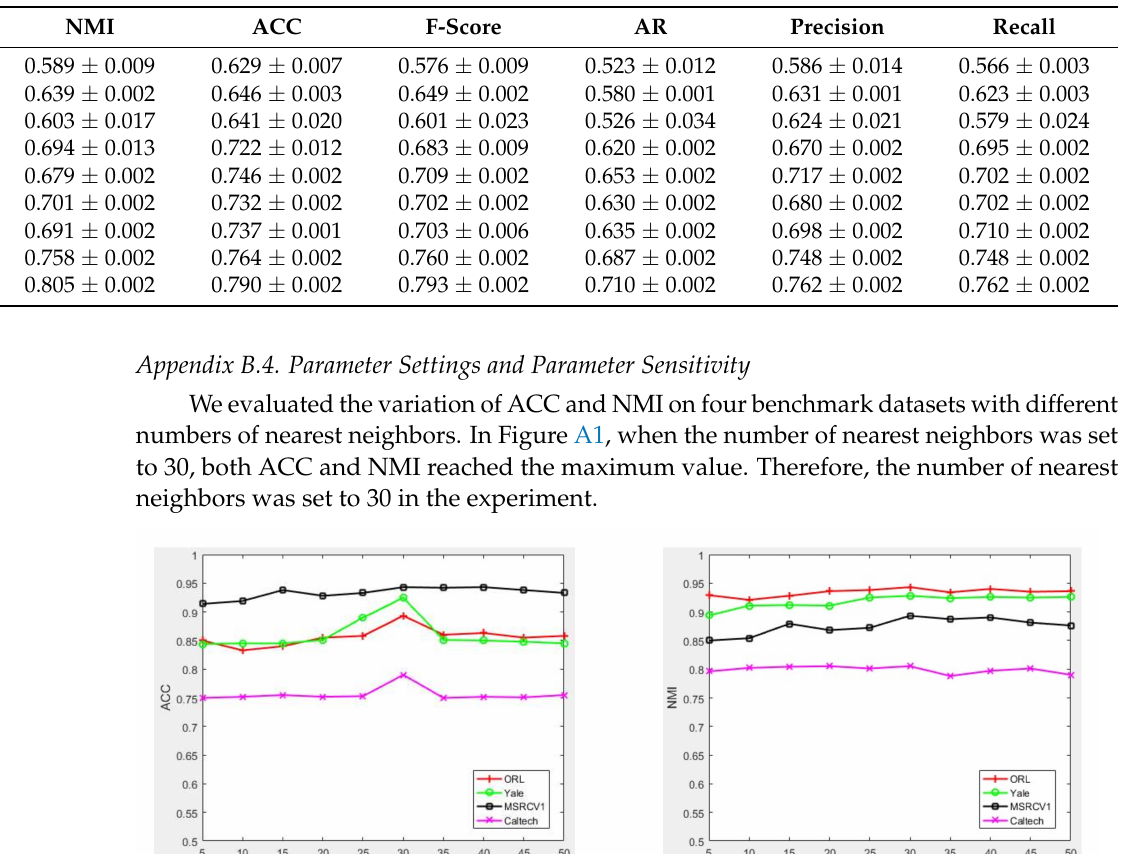
Table A5. Clustering results of the ten methods on Caltech101.